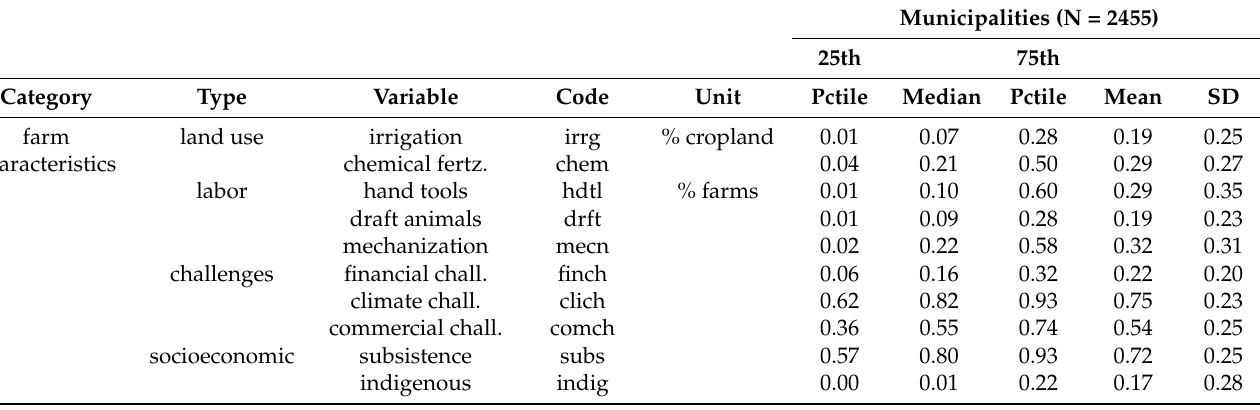
Table 1. Descriptive characteristics of